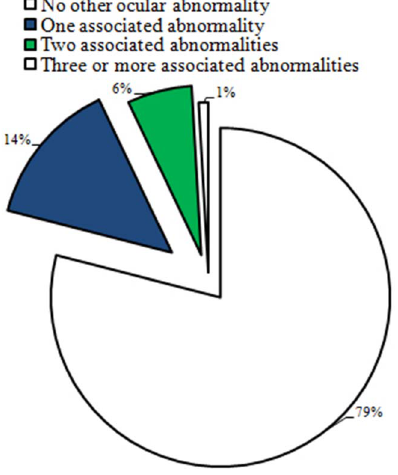
Figure 4. Distribution of patients with other ocular abnormal-